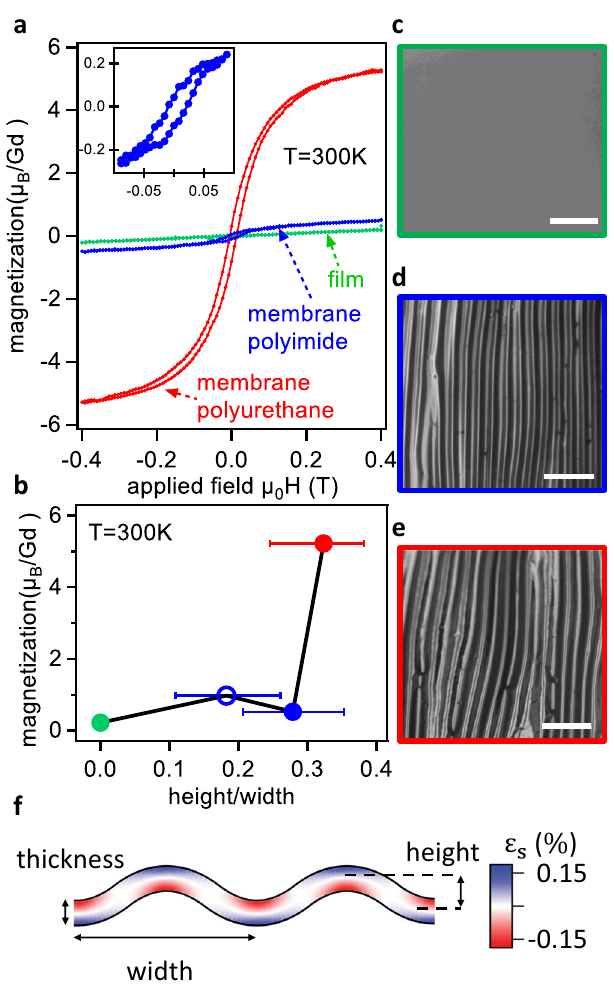
Fig. 5 Strain-induced magnetism in rippled GdPtSb membranes. a Magnetization of GdPtSb thin fi lm directly grown on a sapphire substrate (green), exfoliated GdPtSb membrane adhered to polyimide (blue) and polyurethane (red). The applied fi eld H is oriented out-of-the sample plane, i.e., the global [111] direction. Both membranes have a thickness of 14nm. b Room-temperature magnetization at 0.4Tesla versus ripple aspect ratio (height/width). Relaxed fi lm (green), rippled membrane on polyimide ( fi lled and open blue circles), rippled membrane on polyurethane (red). The ripple height and width are measured by phase-contrast optical microscopy. The error bar represents the distribution of aspect ratio over several regions of the rippled membranes. c – e Optical microscope images of the fi lm c , rippled membrane on polyimide d , and rippled membrane on polyurethane e , respectively. The scale bar is 100 μ m. f Estimate of the strain ϵ s for a sinusoidal membrane with peak to peak width (wavelength) 20micron, ridge to valley height 5 micron, and thickness 14nm, consistent with the dimensions of the membrane on polyurethane. Details in Supplementary Fig.